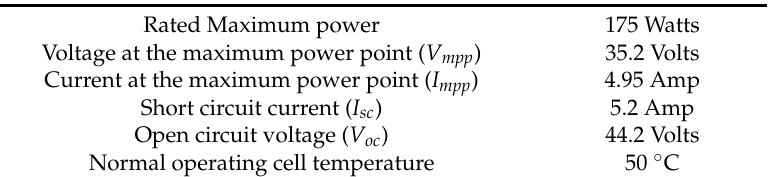
Table 3. The parameters of the solar panel STP175s-24/AC at STC.